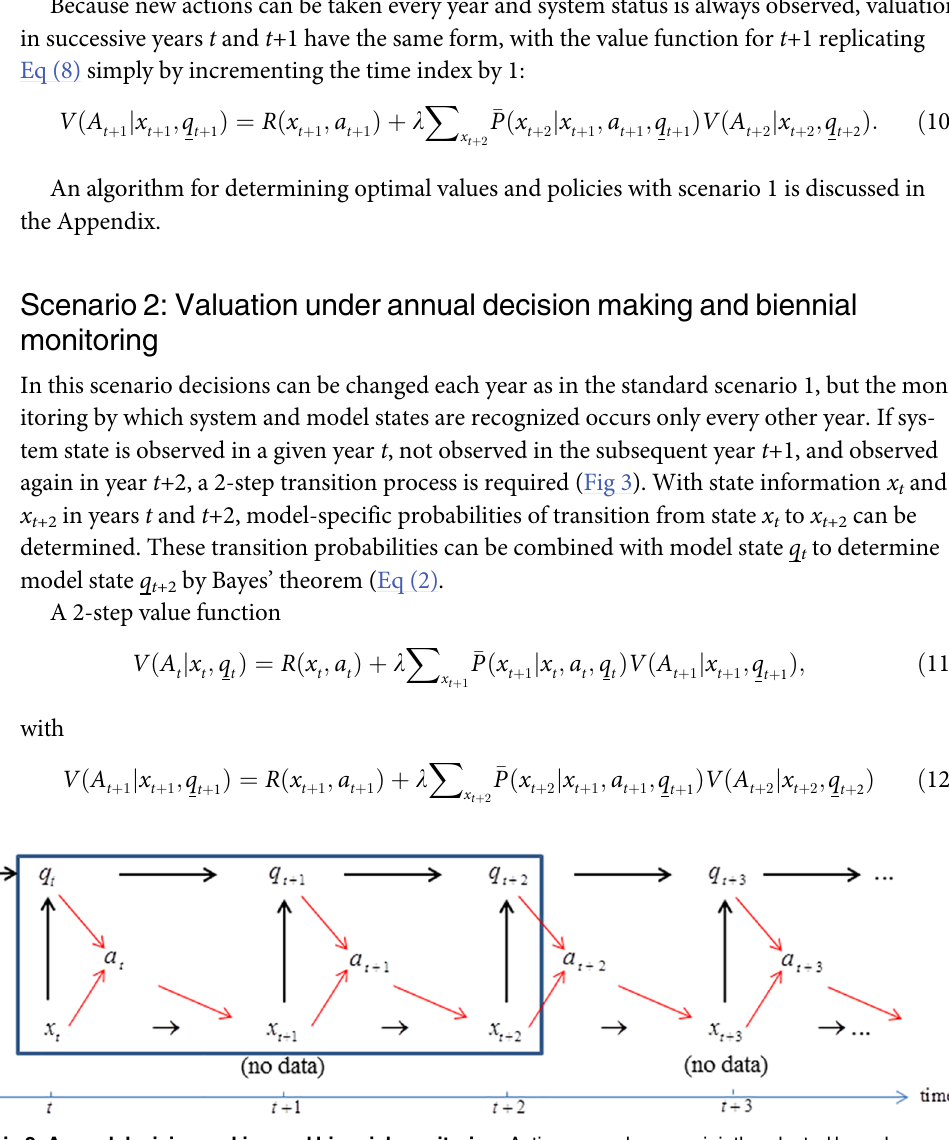
Fig 3. Scenario 2: Annual decision making and biennial monitoring. Actions a t and a t +1 are jointly selectedbased on system state x t and model state q t . Realizedsystem state x t +2 is identifiedthrough monitoringin year t +2. Model state q t is updatedto q t +2 by Bayes’ theorem. This sequence,with actions a t and a t +1 jointly chosen for successive years, is repeated over the remainder of the time frame.